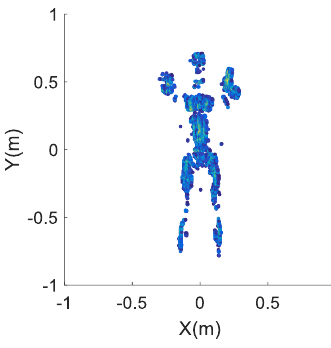
Figure 9. Scattering model of human.